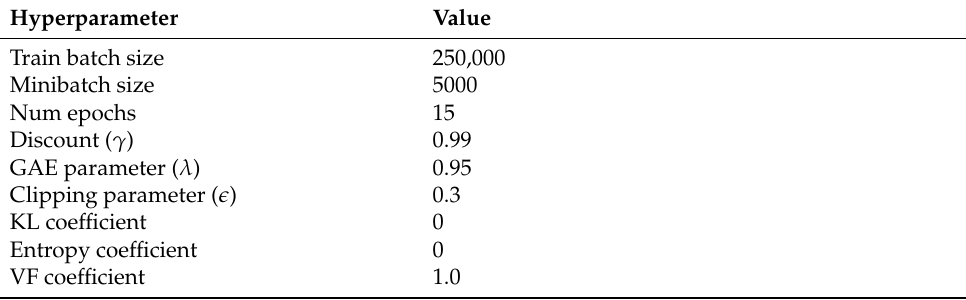
Table A4. Proximal Policy Optimization training